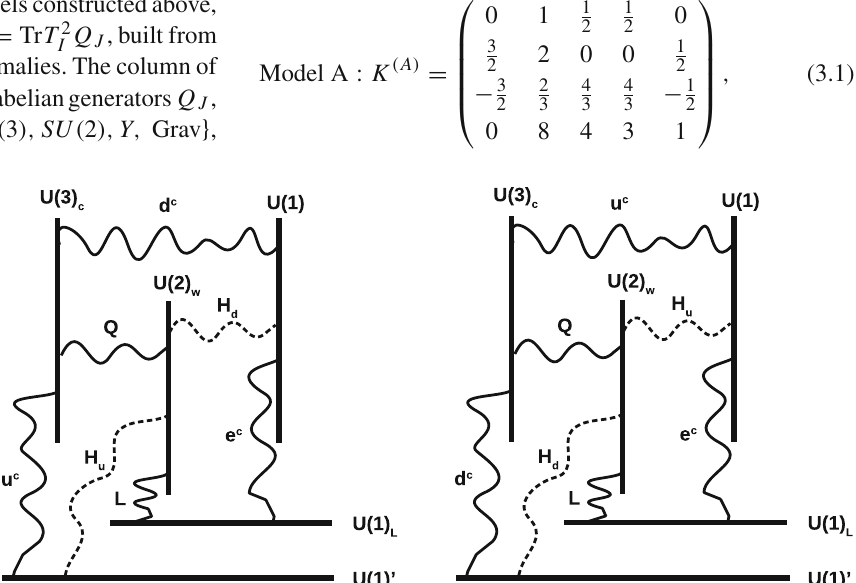
Fig. 1 Pictorial representation of models A and